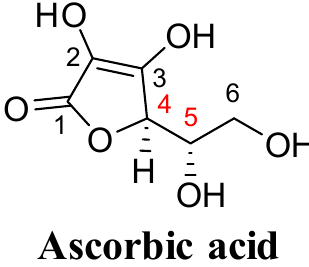
Figure 4. Numbering of the different carbon atom of L-ascorbic acid (4R, 5S).